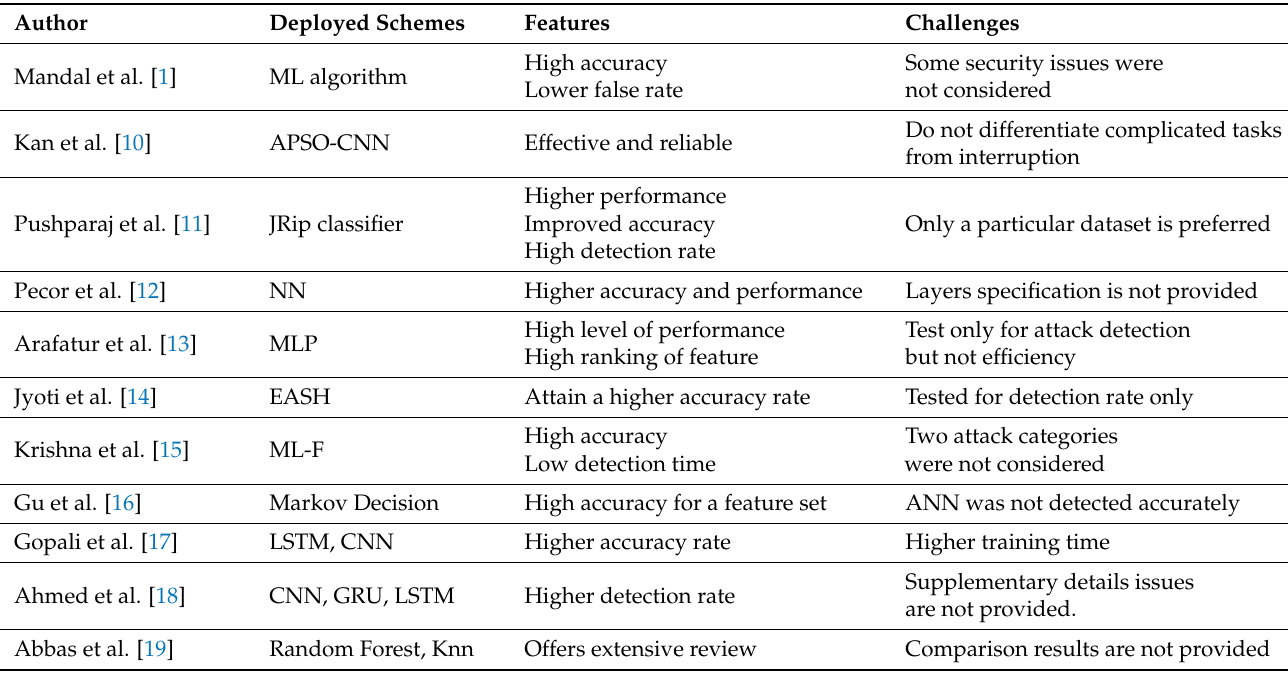
Table 1. Reviews on conventional IoT attack detection models.